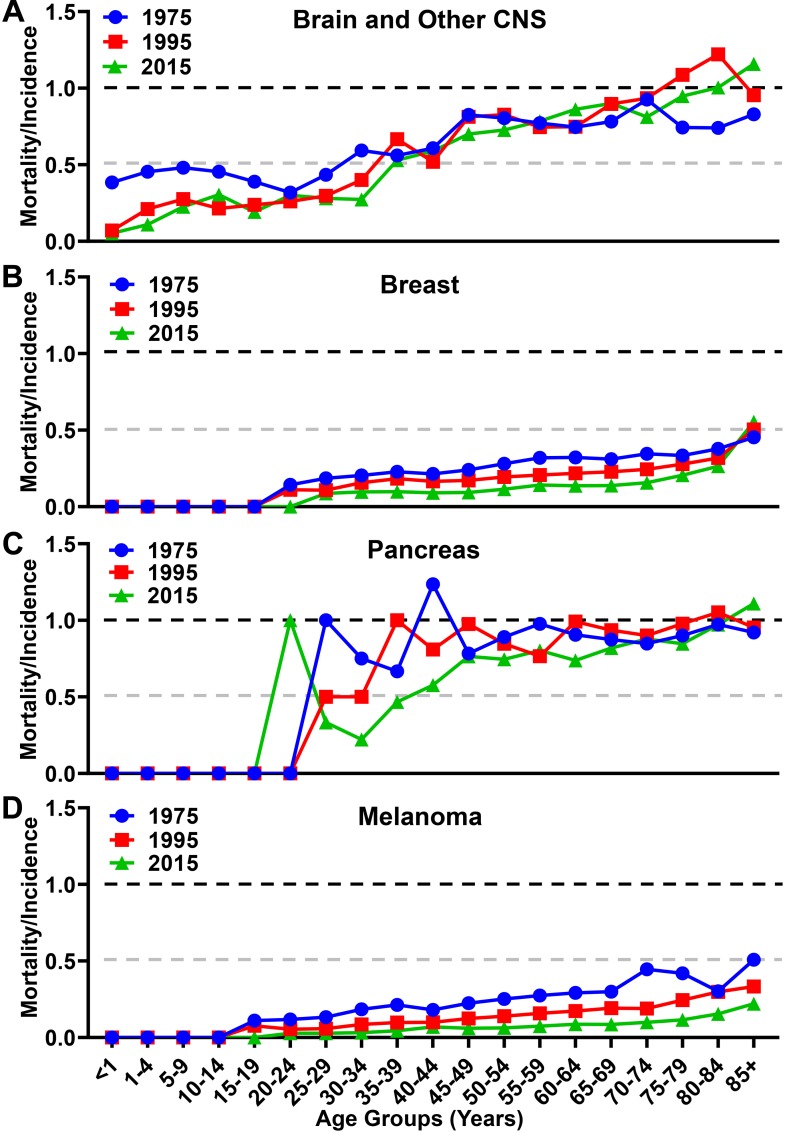
Mortality to incidence ratio for brain, breast, pancreatic, and melanoma malignancies over time. The calculated mortality to incidence ratio of (A) brain and other CNS, (B) breast, (C) pancreatic, and (D) melanoma malignancies for each year calculated from SEER incidence and mortality data. Instances where the ratio is over 1.0 are due to the lag time between diagnosis and mortality in GBM and pancreatic cancer.